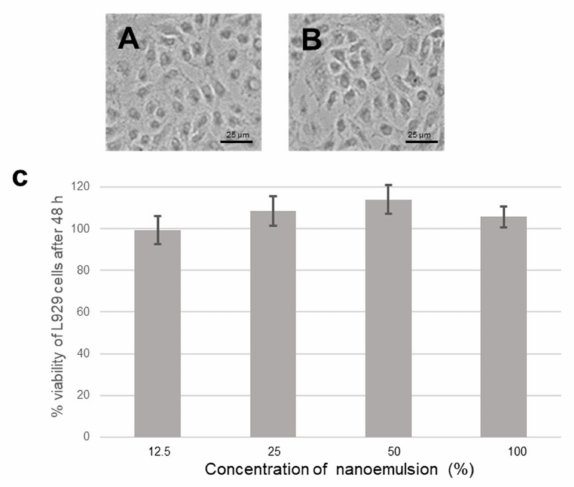
Figure 4. Representative microscopic images of L929 cells treated with nano-emulsion of the sesame-oil extract of turmeric: ( A ) Control and ( B ) treated with formulation 100% (0.2 g / mL). ( C ) Graph showing percentage viability versus concentration of nano-emulsion analyzed using MTT